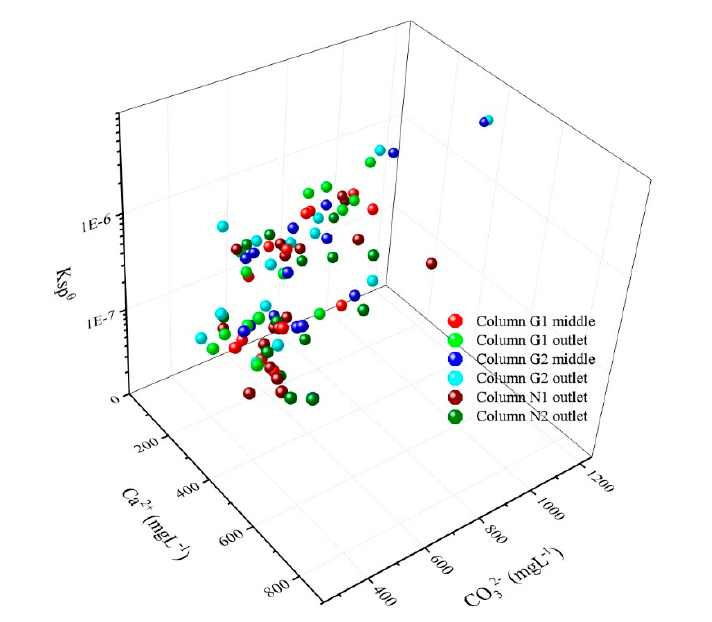
Figure 10. The measured critical solubility product of CaCO3 precipitation.